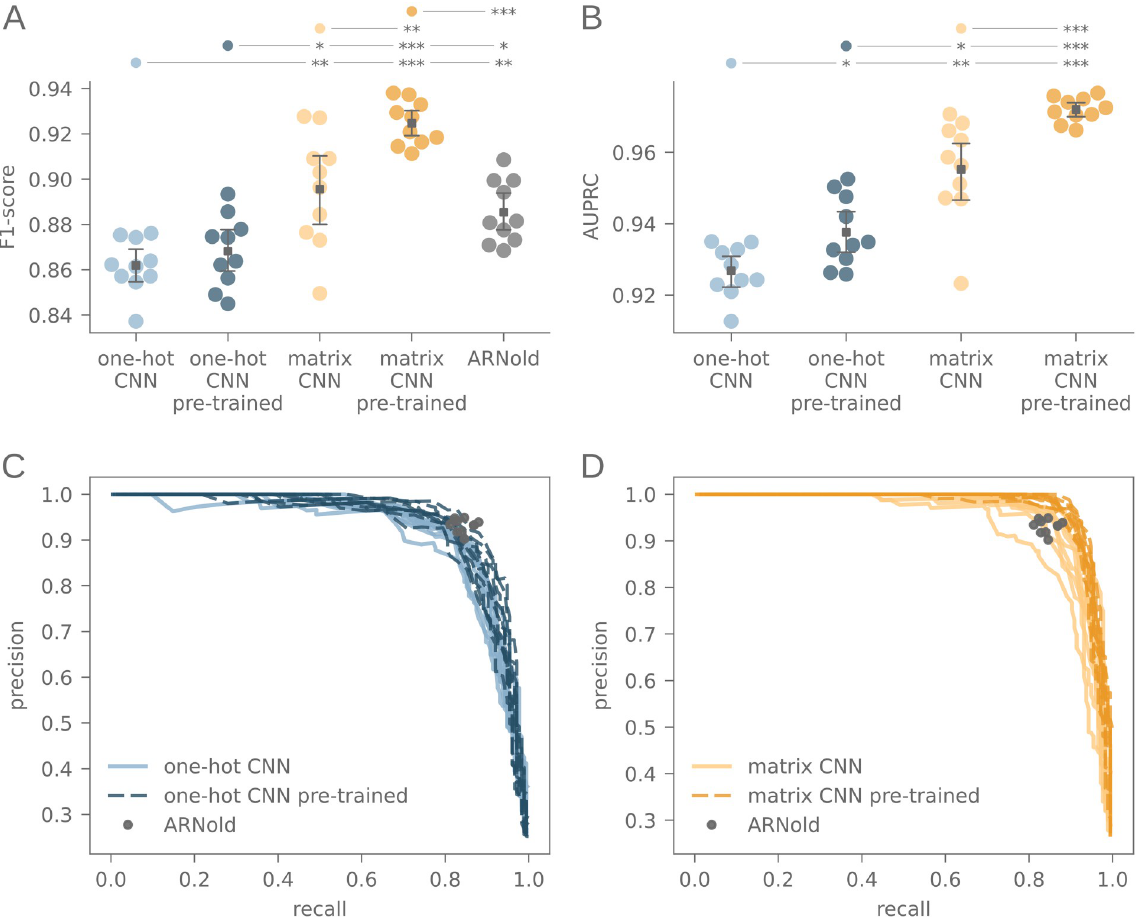
Fig 3. Performance comparisons. F1-score (A), area under precision-recall curve (B) and precision-recall curve (C, D) of one-hot CNN and matrix CNN with and without pre-training. The performance of ARNold on the same validation data is indicated in grey. The p-value of the Wilcoxon rank-sum test between each model x and y is indicated as coloured dot above model x , and as asterisks above model y , with � : p � 0.05, �� : p � 0.005, ��� : p � 0.001.